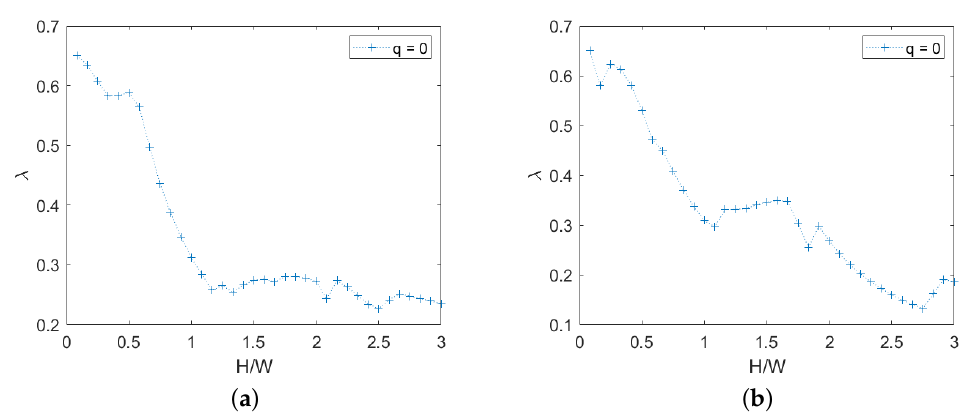
Figure 11. Chaotic masonry, failure multipliers for q = 0: ( a ) right-oriented force, ( b ) left-oriented